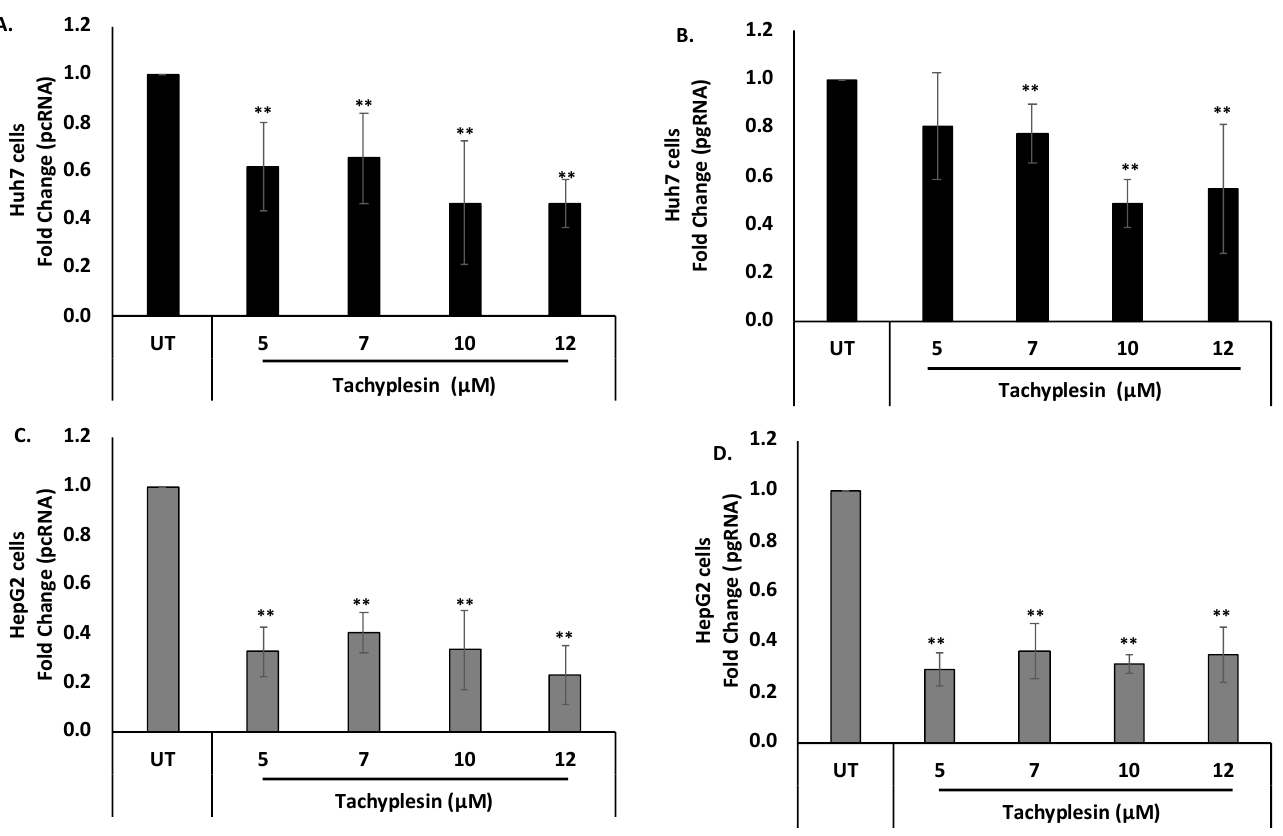
Figure 5. Reduction of HBV pcRNA and HBV pgRNA levels. Tpl led to the reduction of ( A ) HBV pcRNA and ( B ) HBV pgRNA in Huh7 cells. Significant reduction in levels of ( C ) HBV pcRNA and ( D ) HBV pgRNA was also observed in HepG2 cells treated with Tpl. GAPDH was used for normalization. ** represents significant difference with respect to untreated ( p - value < 0.01, Student’ s t -test). UT = untreated control.